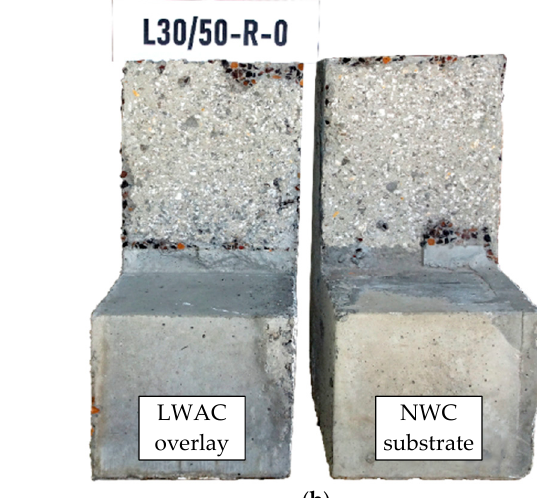
Figure 14. View of the test specimens with smooth interface after failure: ( a ) L30/30-S-0, ( b ) L30/50-S-0.